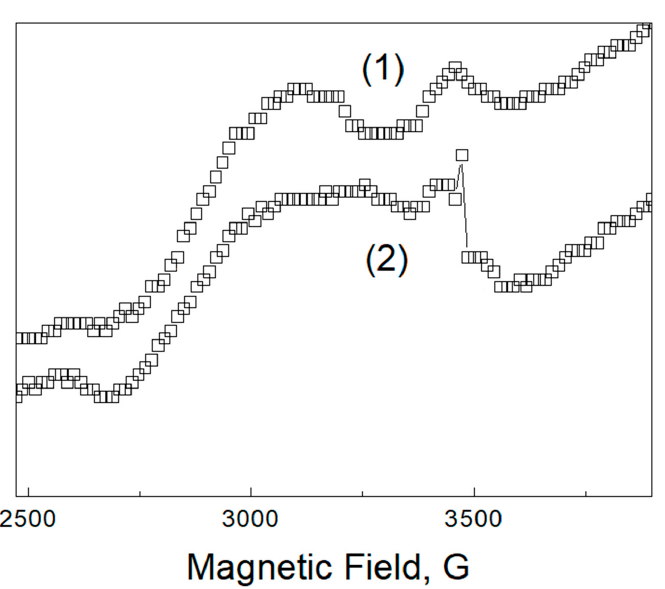
Figure A1. Room temperature EPR spectra of polyethylene before (1) and after temperature treat- ment (2). The lines in this spectrum are weaker and significantly broader in comparison with Pd -containing samples.